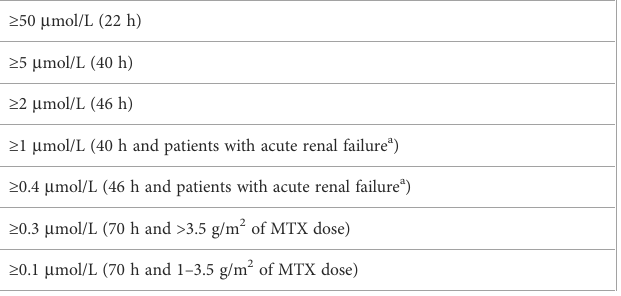
TABLE 1 Selection criteria for the treatment of CPG2. Plasma MTX concentrations and time after MTX